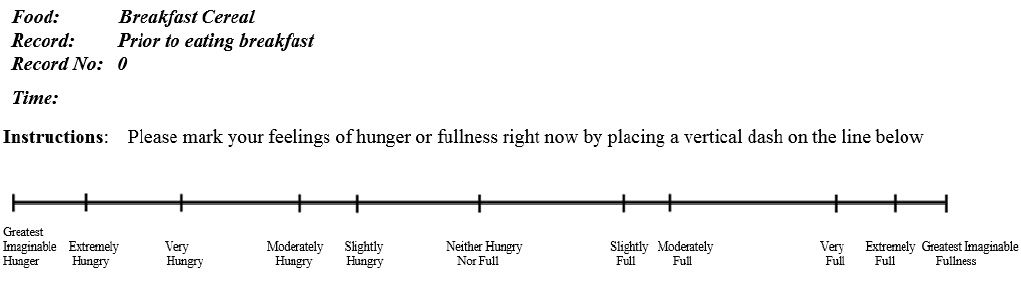
Figure 1. Labelled magnitude scale used to assess satiety. Table 1. Nutrient composition of standard meal and water, excluding test fibre.